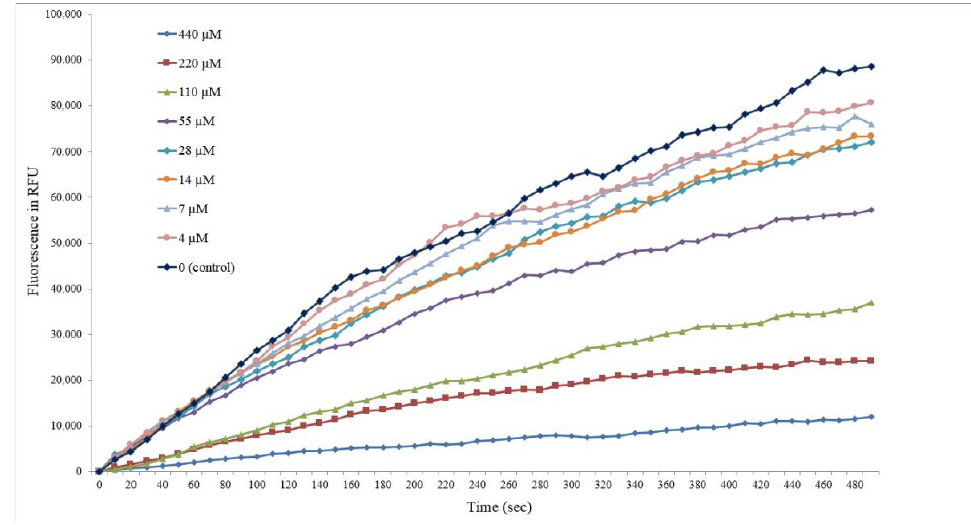
Figure 2. Fluorescence change depending on inhibitor concentration agent 6 .